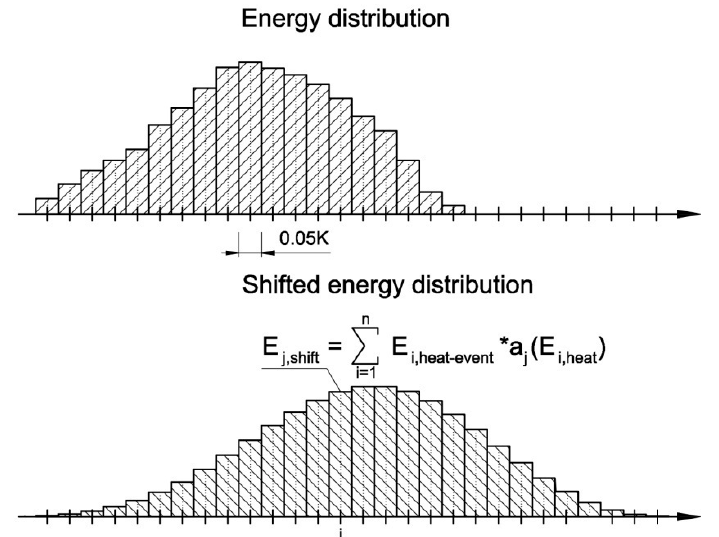
Figure 8. Apparatus function for the single thermal pulse E i,heat-event .